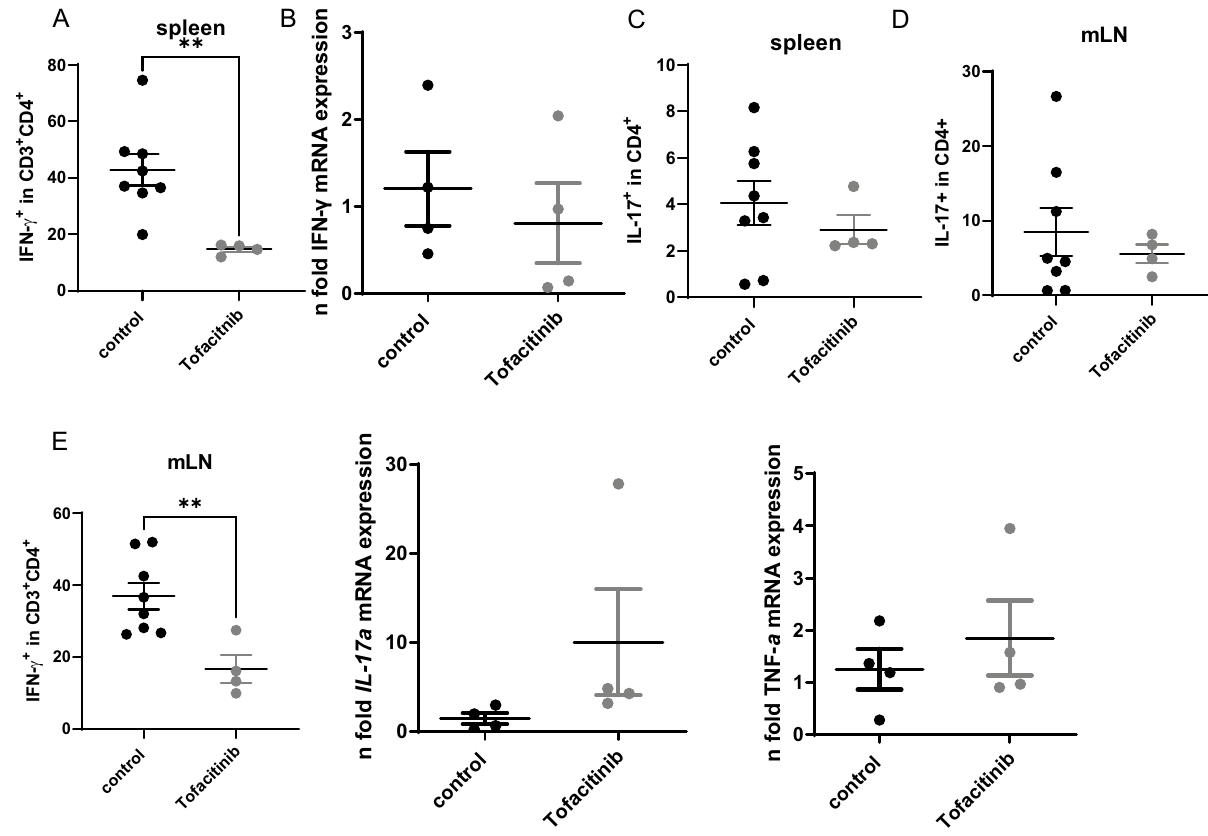
Figure 7. Tofacitinib treatment after onset of colitis reduces IFN-γ secretion. ( A ) Statistical analysis of IFN-γ+ T cells within the spleen, (N = 8 control mice and N = 4 Tofacitinib treated mice, ** = 0.0060)). ( B ) Statistical analysis of IFN-γ+ T cells within mLNs, (N = 8 control mice and N = 4 Tofacitinib treated mice, ** = 0.0070). ( C ) Statistical analysis of IL-17+ T cells within the spleen, (N = 8 control mice and N = 4 Tofacitinib treated mice). ( D ) Statistical analysis of IL-17+ T cells within mLNs, (N = 8 control mice and N = 4 Tofacitinib treated mice. ( E ) Expression of inflammatory cytokines analyzed by RT-qPCR, N = 4 c mice in each group. For A-C, error bars indicate SEM, two-tailed unpaired t-tests were used to test for